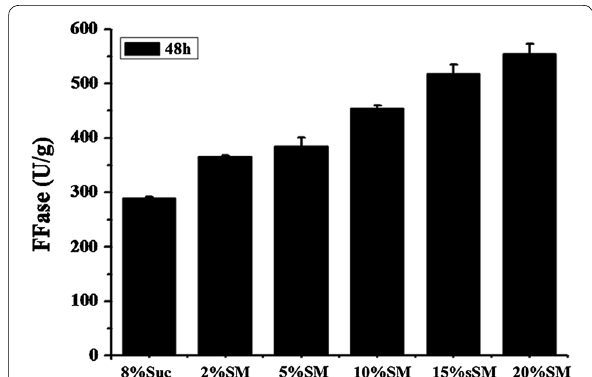
Fig. 6 Production of FFase by A. tubingensis XG21 using sugarcane molasses (SM) as carbon source. Different amounts of sugarcane molasses (2, 5, 10, 15 and 20%) were used to cultivate A. tubingensis XG21 and the fungal cells were collected after 48 h to examine the FFase activity. 8% sucrose (Suc) was used as the control carbon source for fungal growth. All experiments were conducted in